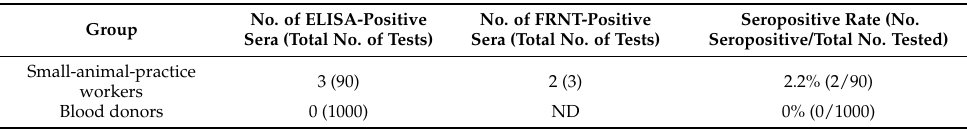
Table 1. Seroprevalence of severe fever with thrombocytopenia syndrome virus in Miyazaki prefec- ture,